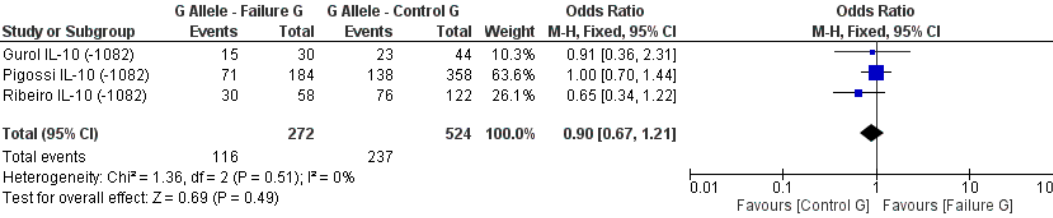
Figure 4. Odds ratio and forest plot for the prevalence of IL10-G1082 allele in the failure group (at least one implant failure) vs. control group (without implant failure). The OR of the combined data crossed the line of no difference.